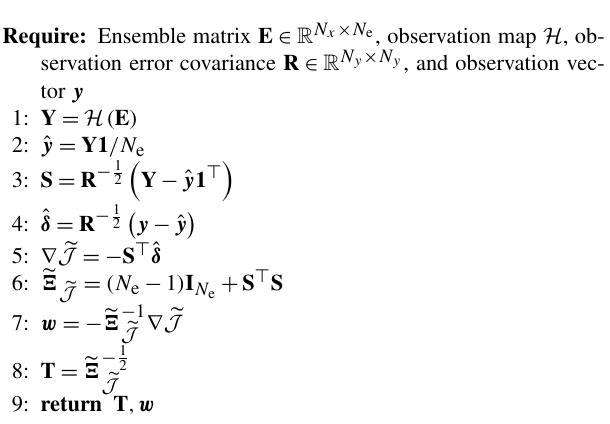
Algorithm A1 Ensemble transform (ET).